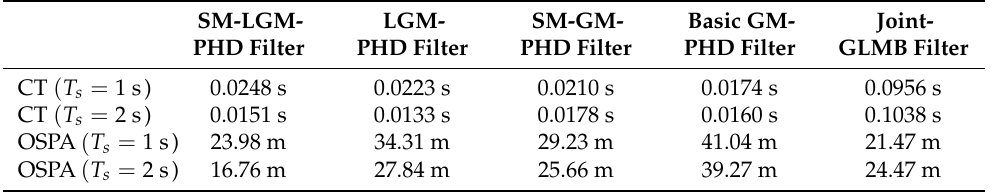
Table 4. List of the average CT and average OSPA of each filter in example 2 (CA